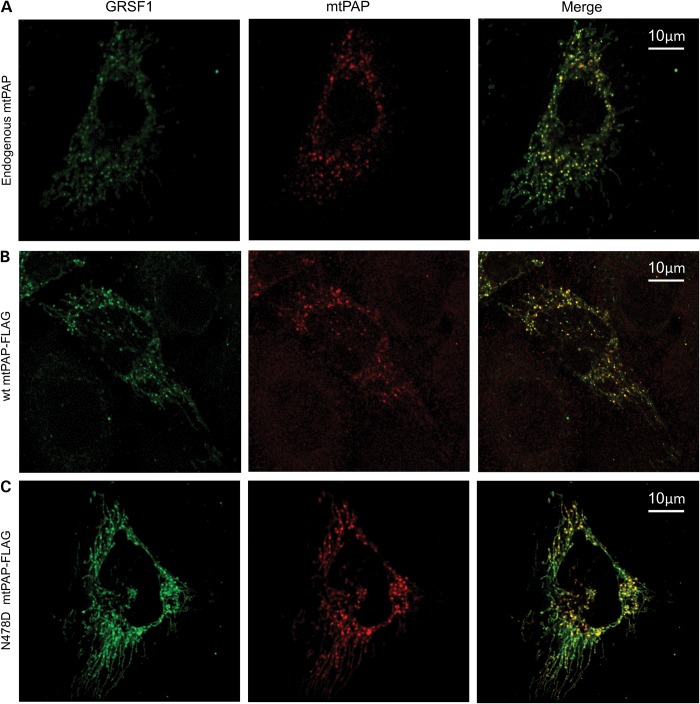
Both wild-type and mutant mtPAP co-localize with mitochondrial RNA granules. (A) HeLa cells expressing an HA-tagged version of GRSF1 isoform 1 (GRSF1) were immunolabelled with anti-HA and anti-mtPAP (endogenous) antibodies and then analysed by confocal microscopy. Images were merged to determine co-localization. (B) HeLa cells transfected to express both HA-tagged GRSF1-HA and a C-terminal FLAG-tagged wild-type mtPAP were immunolabelled using anti-HA and anti-FLAG antibodies and analysed by confocal microscopy. Images were merged to determine co-localization. (C) Similar confocal analysis was performed on HeLa cells transfected to express GRSF1-HA and the p.N478D mutant version of mtPAP-FLAG. Immunolabelling and image analysis was as described in (B).